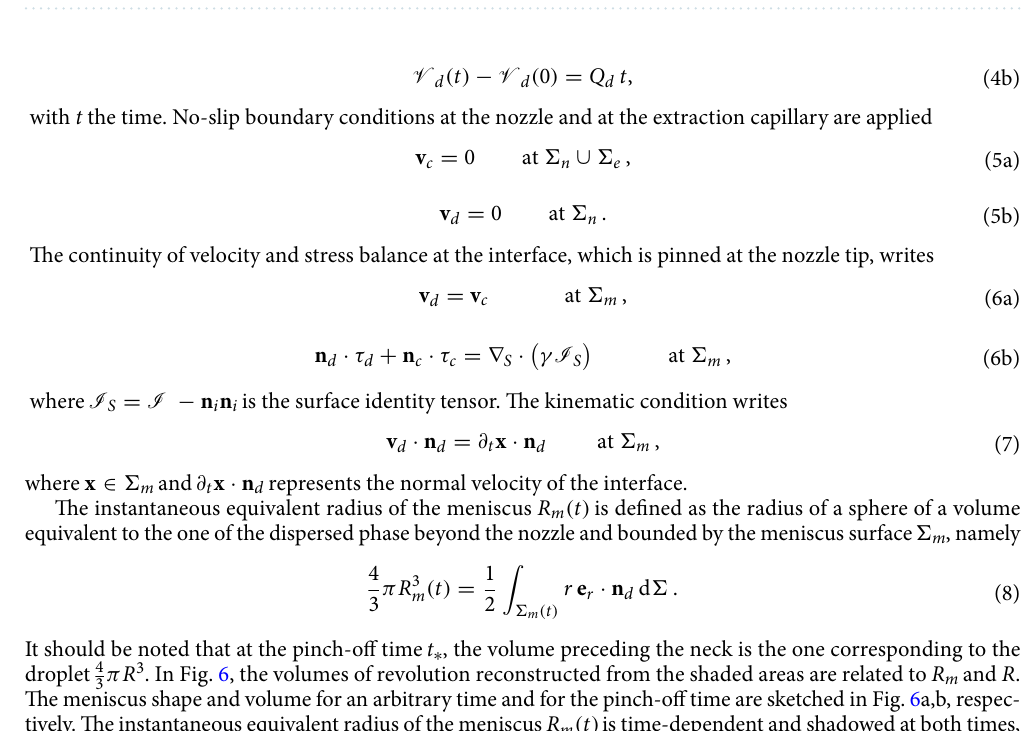
Figure 6. Sketch of the instantaneous equivalent radius of the meniscus R m ( t ) , and of the drop R , ( a ) for an arbitrary time t and ( b ) for the pinch-off time t ∗